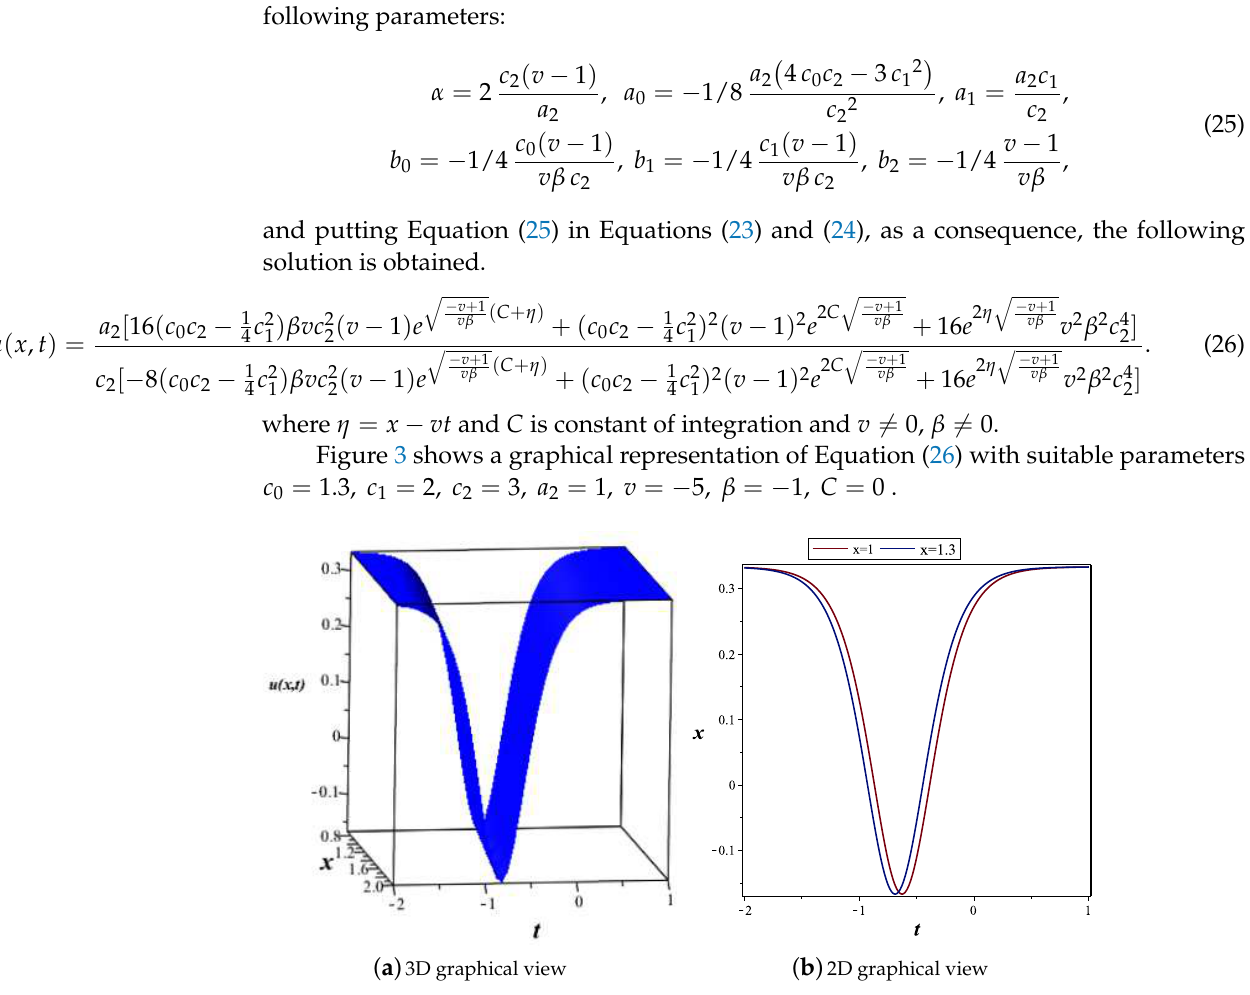
Figure 3. Graphical visualizations of Equation (26) within interval 0.7 ≤ x ≤ 2 and − 2 ≤ t ≤ 1 (( a ) 3D plot, ( b ) 2D plot for x = 1,